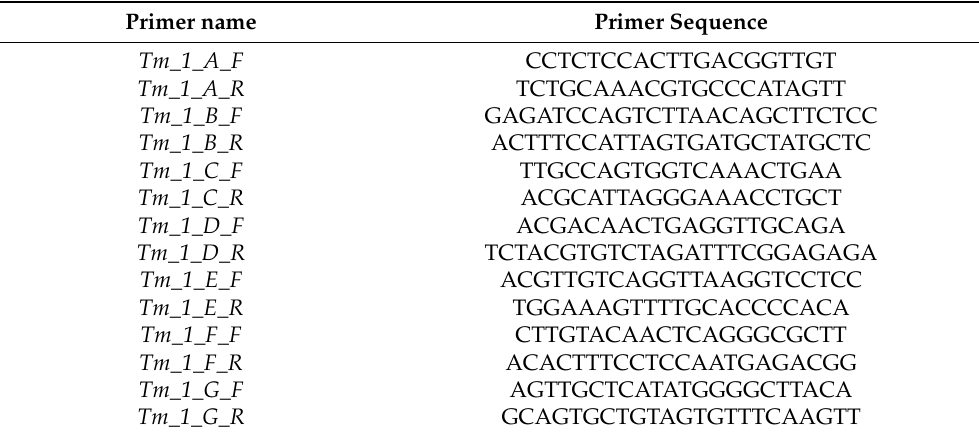
Table 10. Primers used to amplify overlapping fragments of the Tm-1 gene in the resistant VC554